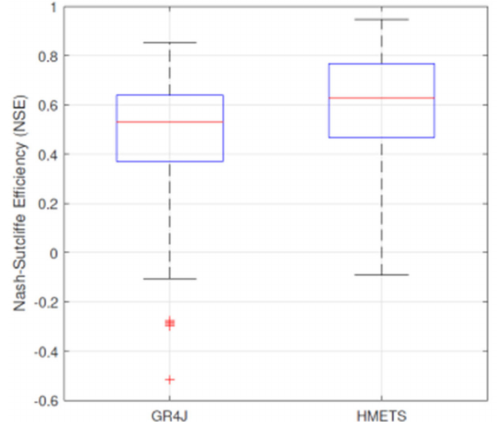
Figure 3. NSE values in the validation (1991–2010) of the two rHMs for the 198 catchments combined. The red line in the box plots represents the median value; the ends of the boxes represent the 25th (lower) and 75th (upper) quantiles; outliers are shown as red